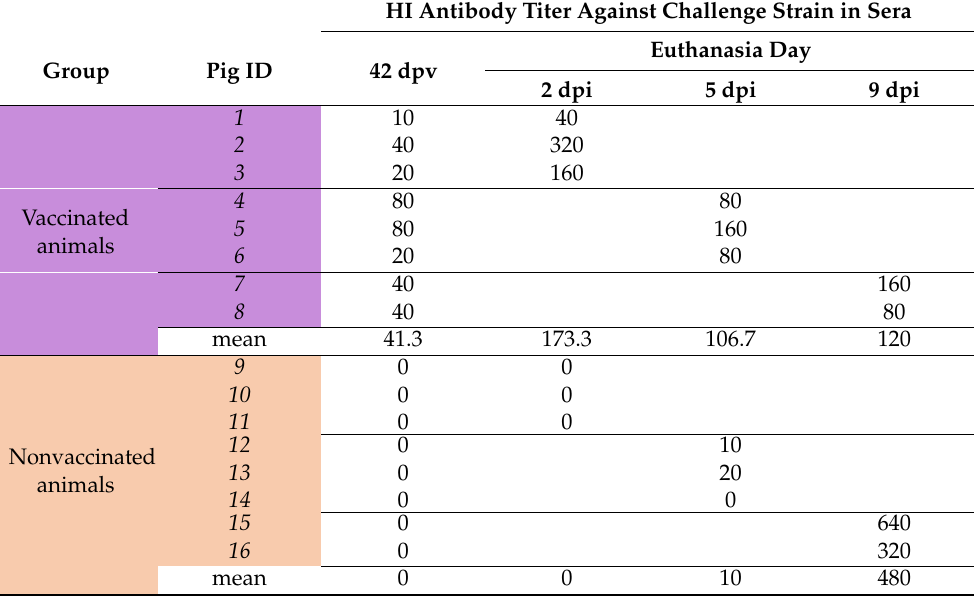
Table 1. HI activity of sera against challenge strain A/Swine/Spain/SF32071/2007 (H3N2).